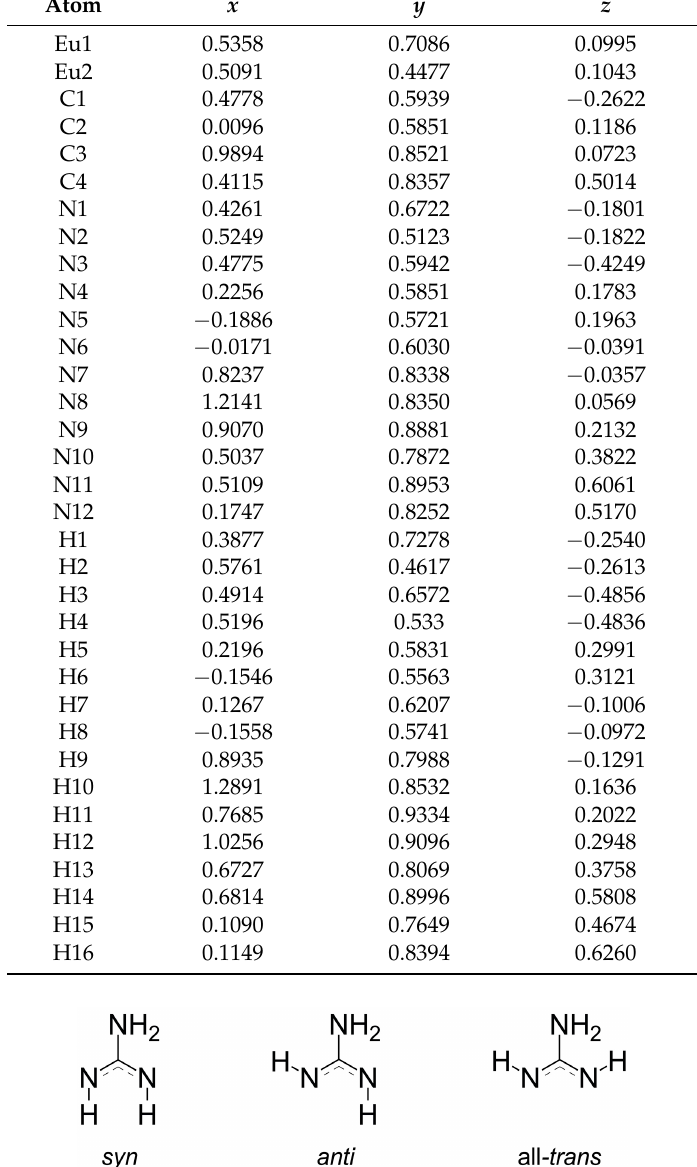
Table 3. Atomic positions of α -Eu(CN 3 H 4 ) 2 in space group P 2 1 (all on Wyckoff position 2 a ) as determined from DFT.